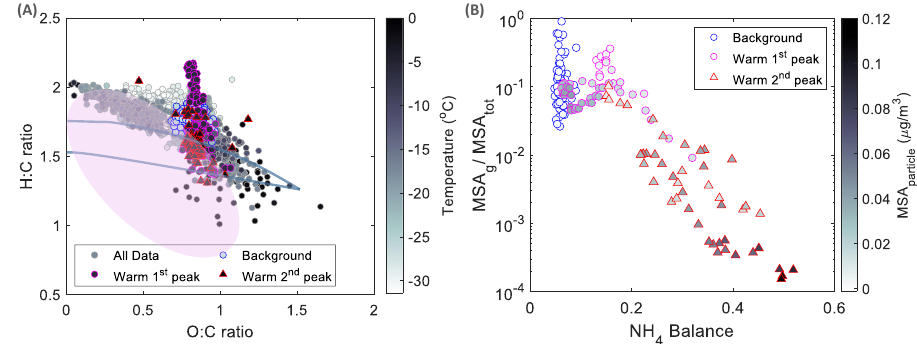
Fig. 5 | Aerosol organic composition, acidity and MSA partitioning. A Relationship between the estimated hydrogen-to-carbon (H:C) and oxygen-to- carbon (O:C) ratios of organic species as Van Krevelen diagram. The ellipse represents data points below 300m altitude in the summertime Canadian Arctic measured by Willis et al. 55 . Blue lines are from Ng et al. 53 , representative of mid-